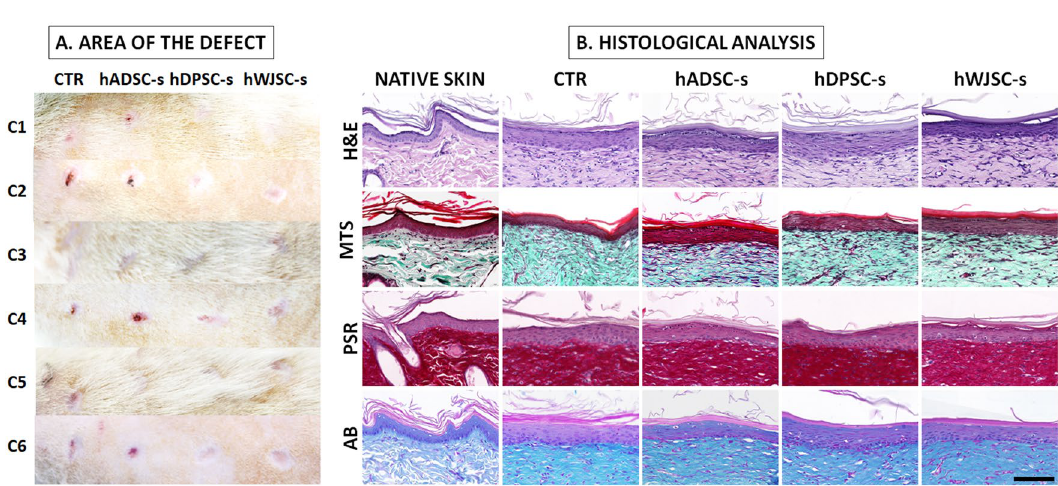
Figure 6. Preliminary in vivo analysis of skin defects treated with each experimental condition after 4 weeks of follow-up. ( A ) Macroscopical images corresponding to each case (C1 to C6). ( B ) Histological analysis using hematoxylin–eosin (H&E), Masson trichrome staining (MTS), picrosirius red (PSR) and alcian blue (AB). Native skin corresponds to histological images of native non-injured skin. CTR control group, hADSC-s human adipose-derived MSC secretome, hDPSC-s human dental pulp MSC secretome, hWJSC-s Wharton’s jelly MSC secretome. The scale bar shown on the last histological image applies to all histological images and represents 100